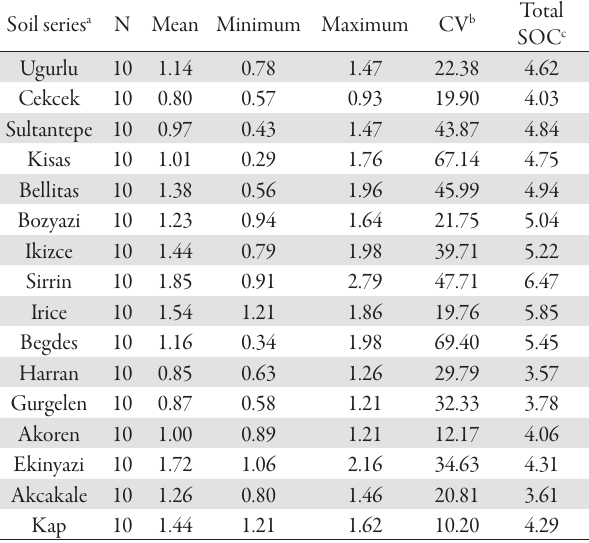
Tab. 4. Carbon amounts of Harran plain soils (kg C m -2 ) Soil series a N Mean Minimum Maximum